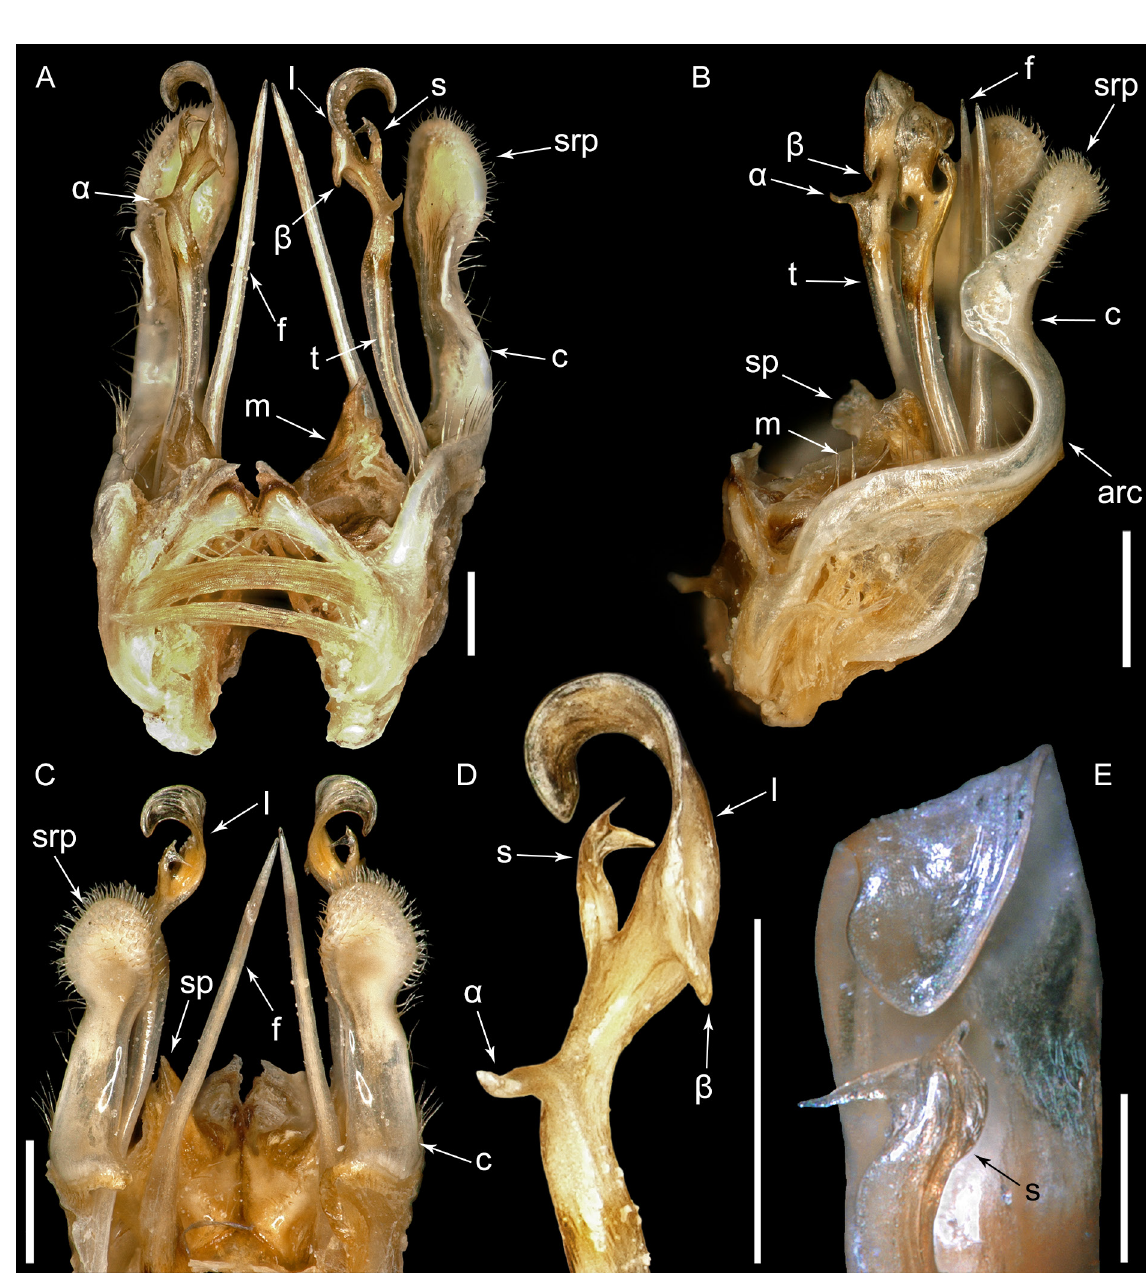
Fig. 5. Gonopod of ♂ paratype (MNCN 20.07/2071). A . Posterior view. B . Lateral view. C . Anterior view. D . Distal part of right telopodite in posterior view. E . Tip of right telopodite with tip of solenomerite visible. Scale bars: A–D = 0.4 mm, E = 0.1 mm. Abbreviations: α, β = processes of telopodite; arc = semi-circular arc of gonocoxite; c = gonocoxite; f = pseudoflagellum (or hornflagellum); l = lamella; m = membranous structures; s = solenomerite; sp = subrectangular projection of membranous structures; srp = semi-rectangular process of gonocoxite; t =